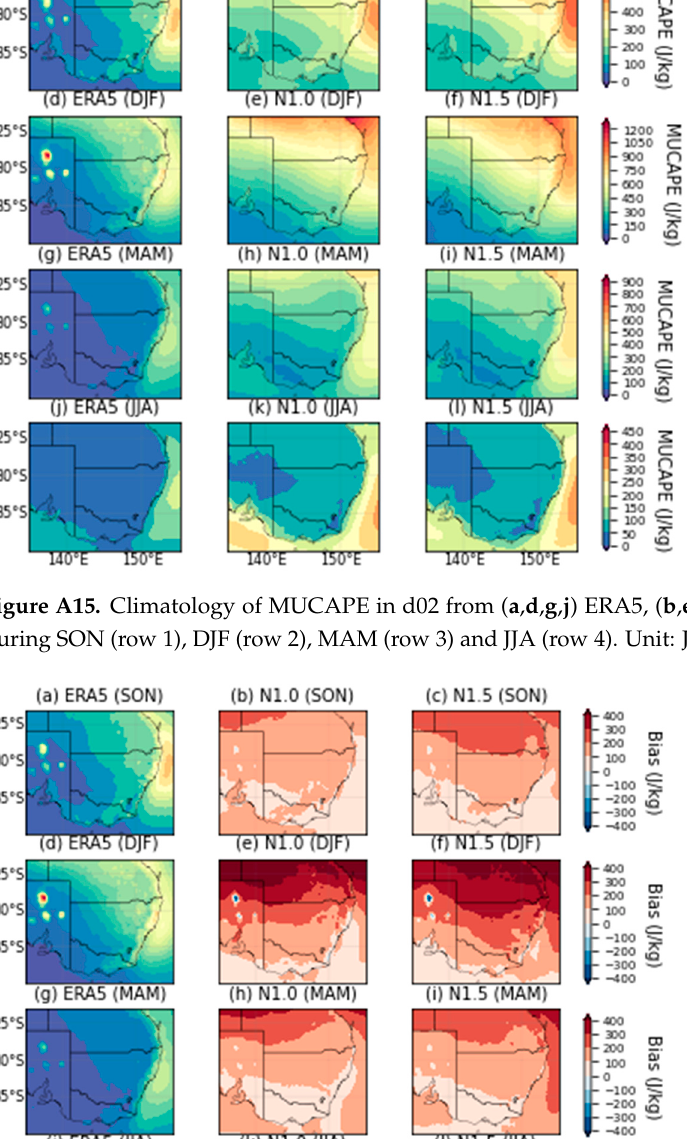
Figure A17. As in Figure A15 except for CIN.